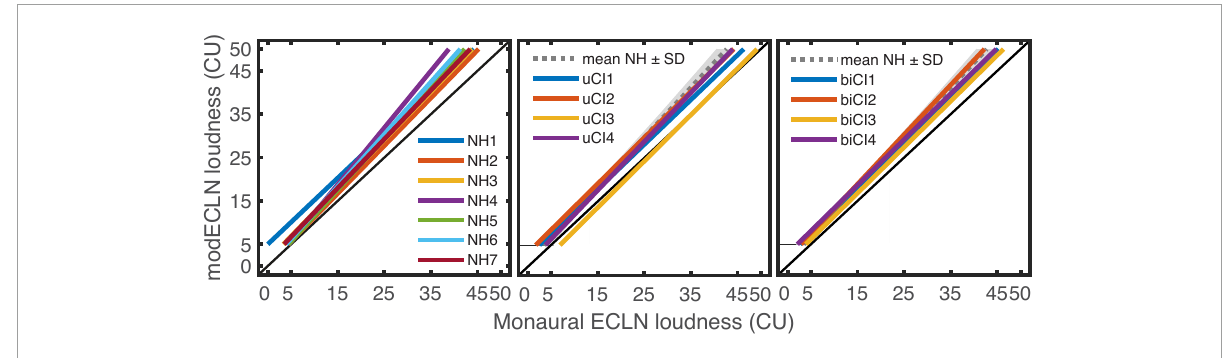
FIGURE7 Regression lines between the loudness ratings of the binaural modECLN presentation and the loudness of the monaural ECLN for the seven NH, four uCI and four biCI listeners. The gray line and areas indicate the averaged NH reference ± one standard